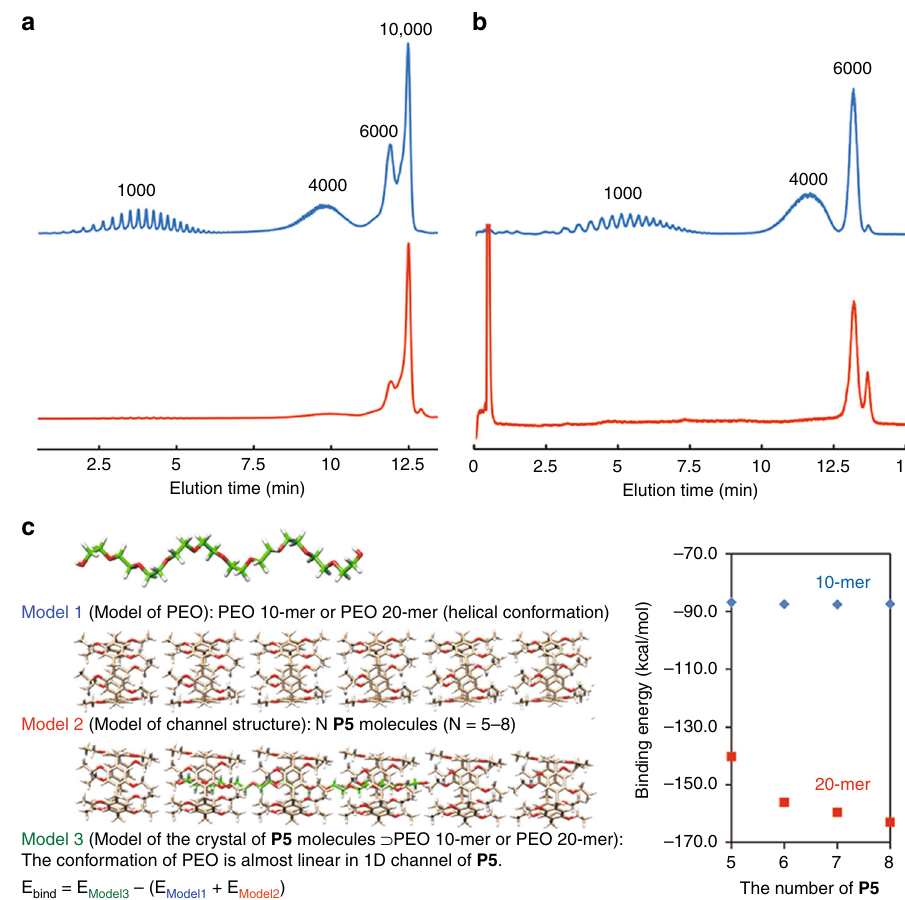
Fig. 3 High mass fractionation by 1D pillar[5]arene channels. Liquid chromatography traces of an equal-weight mixture of PEO (blue lines, a PEO1000-OH, PEO4000-OH, PEO6000-OH, and PEO10000-OH) and b PEO1000-OH, PEO4000-OH, and PEO6000-OH) and P5 crystals after immersion in the mixture (red lines). c Calculated binding energies for PEO 10-mer and PEO 20-mer using model 1 –